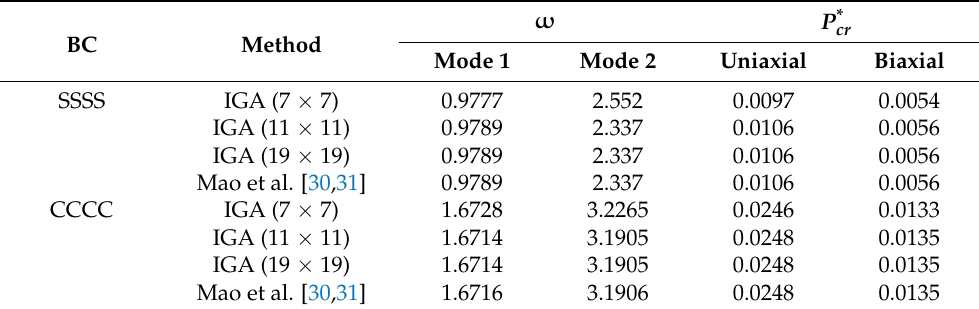
Table 2. Comparison of dimensionless central deflection of square plate on elastic foundation with different boundary